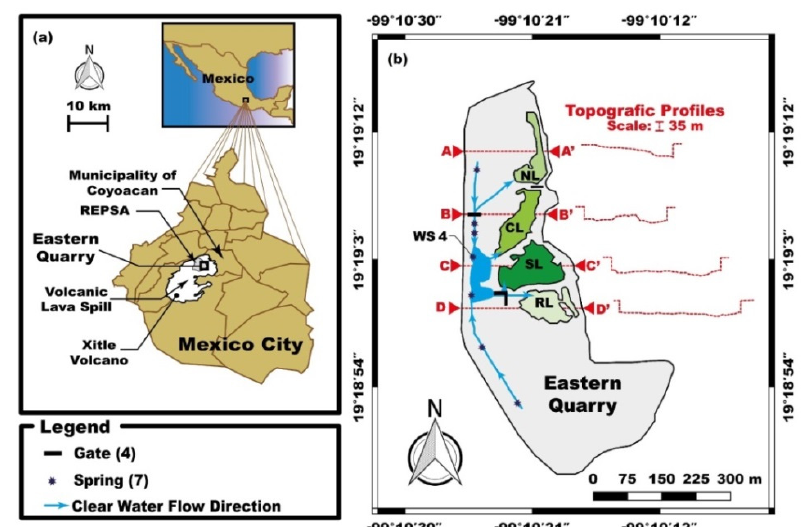
Figure 1. ( a ) Study site location, Xitle volcano, and lava spill; ( b ) Eastern Quarry (EQ) map showing the lakes [North Lake (NL), Central Lake (CL), South Lake (SL), and Regulation Lake (RL)] and their appearance (green color intensity is analogous to that observed in the field), springs [Spring Puddle 4 (WS 4)], gates, water supply flow, and topographic profiles.